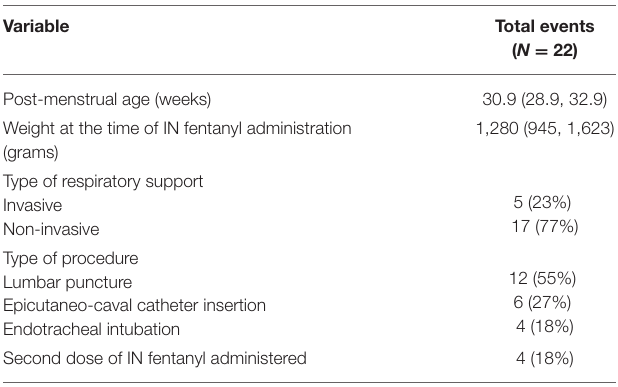
TABLE 2 | Clinical characteristics of patients at IN fentanyl